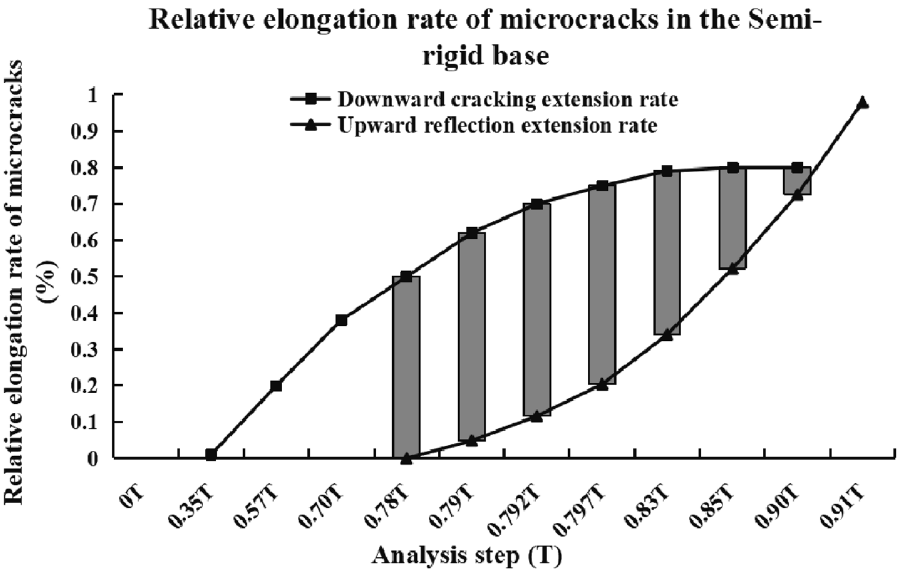
Fig. 5 Relative elongation rate of micro-cracks in the Semi- rigid type